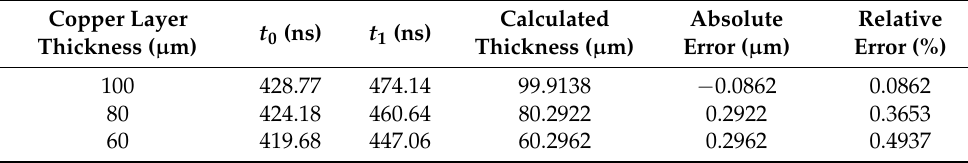
Table 2. The thickness of the copper layer calculated based on simulation